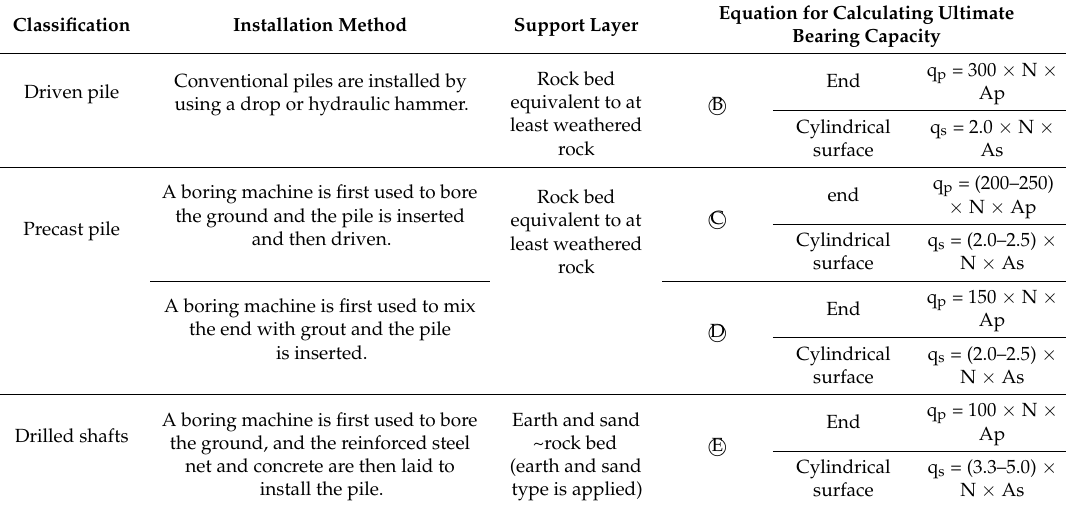
Table 8. Characteristics depending on the installation method and experimental equations for calculating bearing